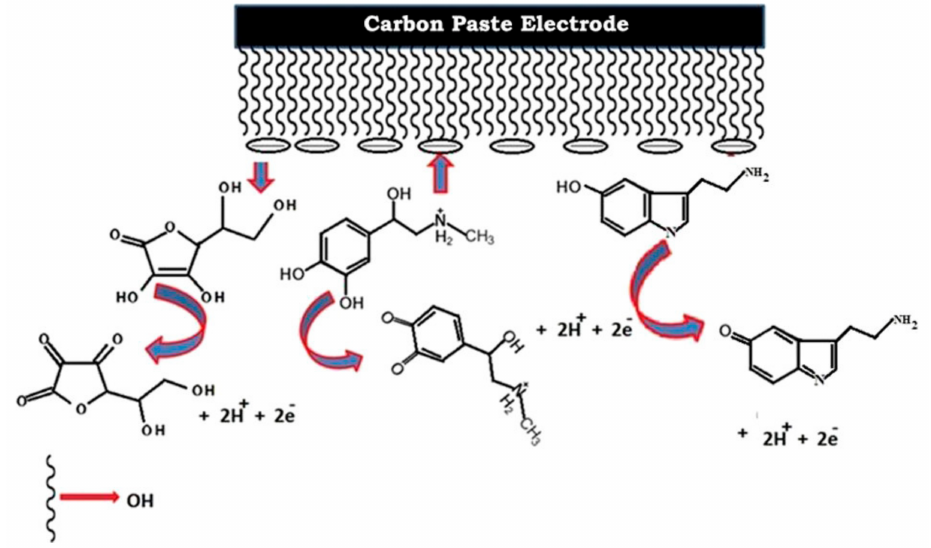
Figure 8. Mechanism of sensing and oxidation of ascorbic acid (AA), adrenaline (AD), and serotonin (5-HT) on CQDs/carbon paste electrode (CPE). Reprinted from Ref.